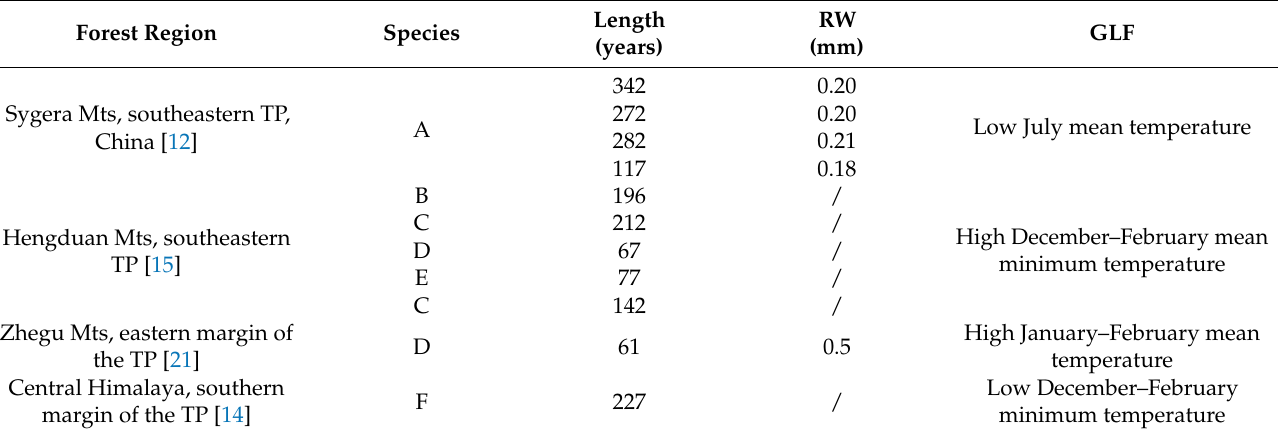
Table 4. Information for the existing Rhododendron shrub chronologies in previous studies on the TP. Rhodo- dendron shrub species included Rhododendron aganniphum var. schizopeplum (A), Rhododendron phaeochrysum (B), Rhododendron. traillianum (C), Rhododendron przewalskii (D), Rhododendron alutace (E), and Rhododen- dron campanulatum (F). The sign “/” indicates no data. Abbreviations: shrub species (Species), length